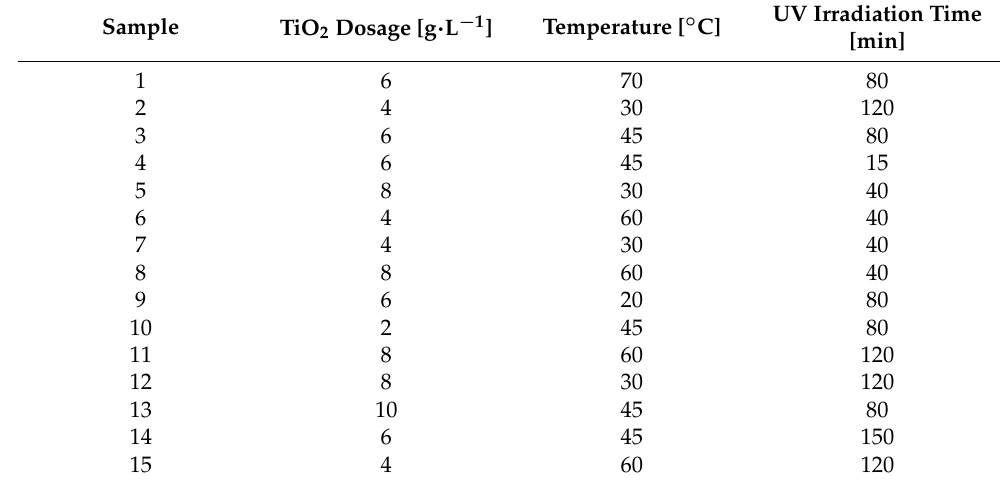
Table 1. The input variables for experimental design.